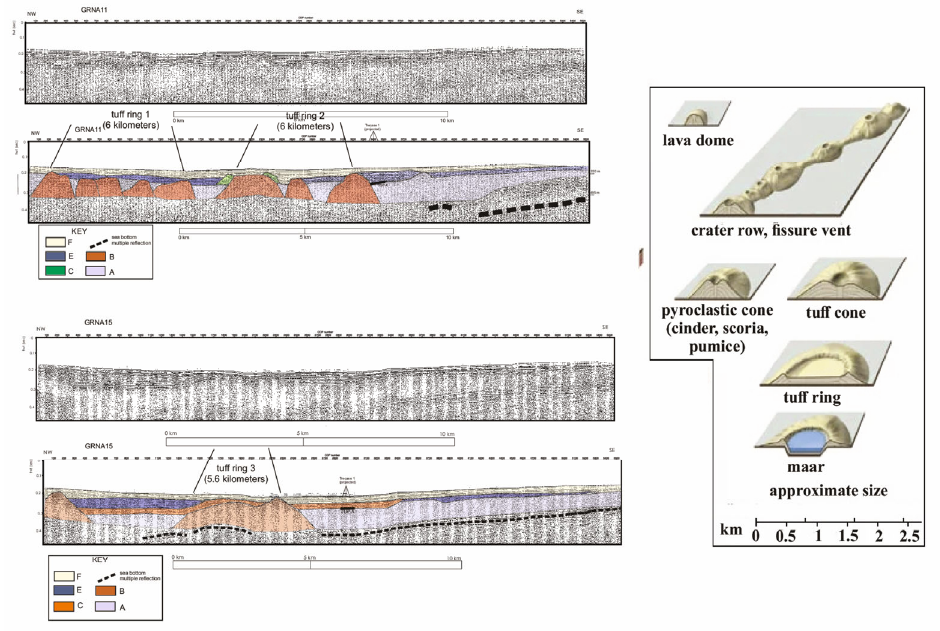
Figure 12. Sketch showing the geological constraints used for the interpretation of the B seismic unit. On the right side of the figure, several types of volcanic edifices were represented, based on the volcanological literature in order to show the shape and the approximate size of the tuff rings. On the left side of the figure, the GRNA11 and GRNA15 seismic profiles were reported (Figures 7 and 8), showing the interpretation of the volcanic edifices interpreted as tuff rings in the eastern sector of the Bay of Naples. Note that the dimensions of the volcanic edifices, measured on the seismic sections and ranging between 5.6 and 6 km, are compatible with those of the tuff rings recognized in literature in the Neapolitan area [11,72].